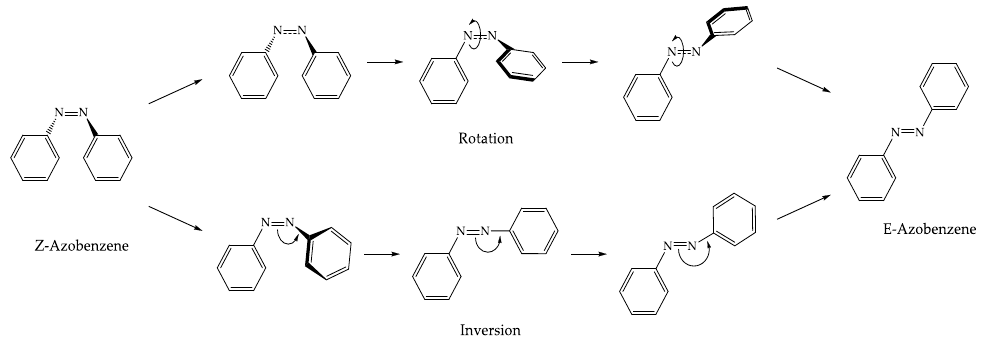
Figure 1. Rotation and inversion thermal relaxation mechanisms for unsubstituted azobenzene.